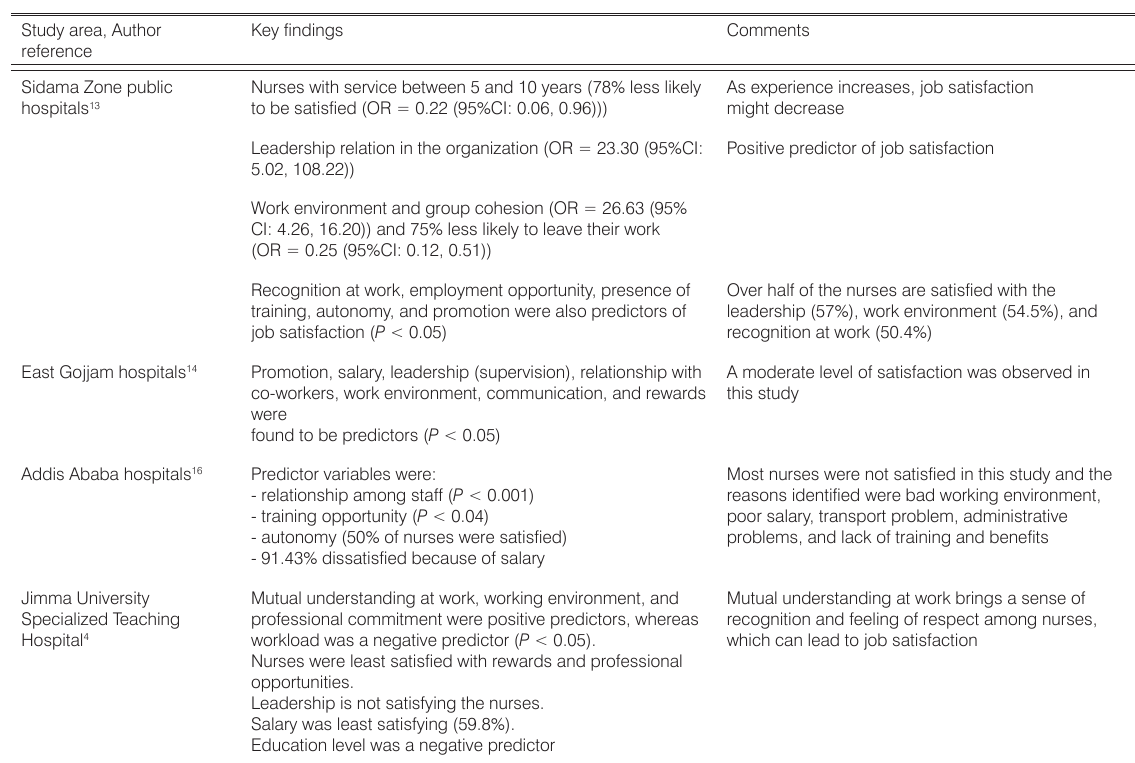
Table 2 . Factors affecting nurses’ job satisfaction in each study of Ethiopia,